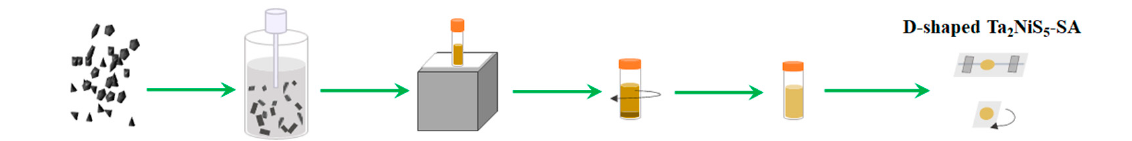
Figure 1. Illustration of the Ta 2 NiS 5 -SA preparation process.